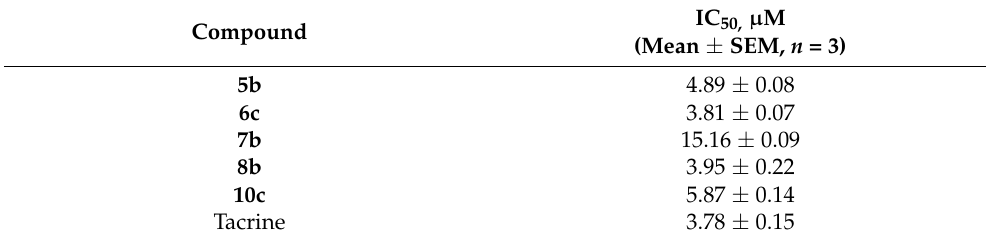
Figure 9. Absorbance of the 5b –Cu 2+ , 6b –Cu 2+ , and 10b –Cu 2+ complexes at 352 nm as a function of the concentration of Cu 2+ (compounds concentration is 20 µM). Vertical dashed lines mark the metal concentration at the breakpoints and indicate ligand–metal molar ratios of 2:1 for 5b , 2.3:1 for 6b , and 1.3:1 for 10b . Table 6. Cytotoxicity of conjugates 5b , 6c , 7b , 8b , 10c and tacrine against mouse